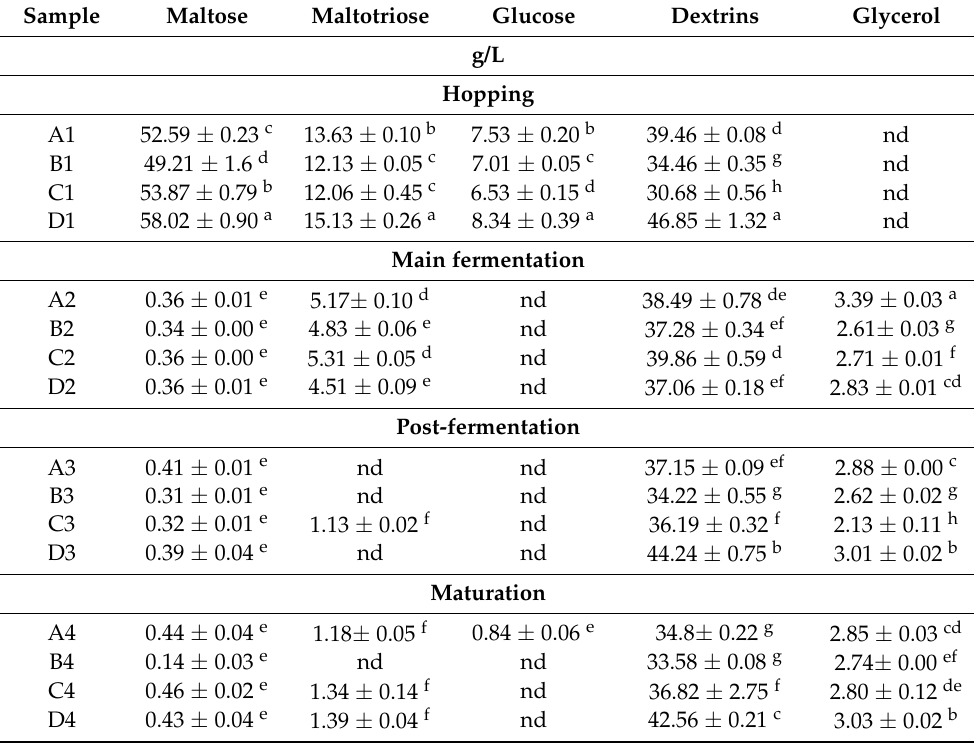
Table 2. Carbohydrate profiles and glycerol content in hopped worts and beers.